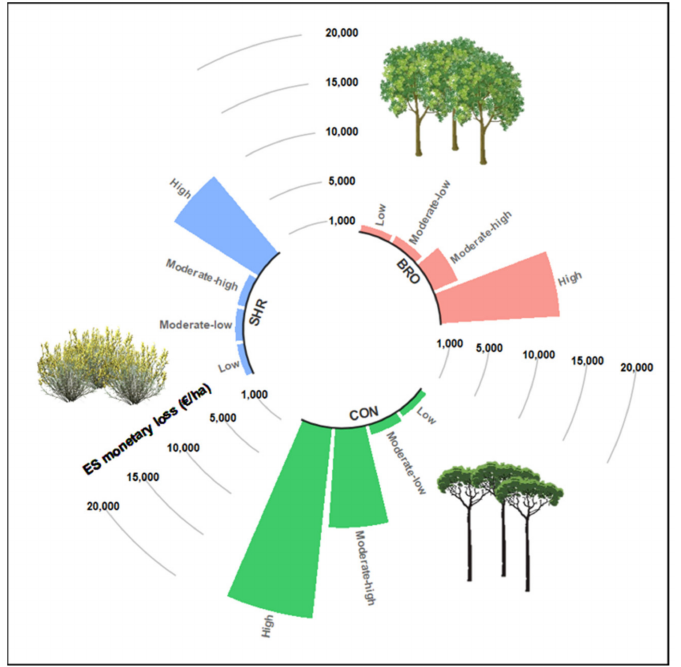
Figure 7. ES monetary loss ( € /ha) according to the severity of wildfires (from low to high severity) experienced by each vegetation physiognomy (BRO–broadleaved forest, CON–conifers, and SHR–